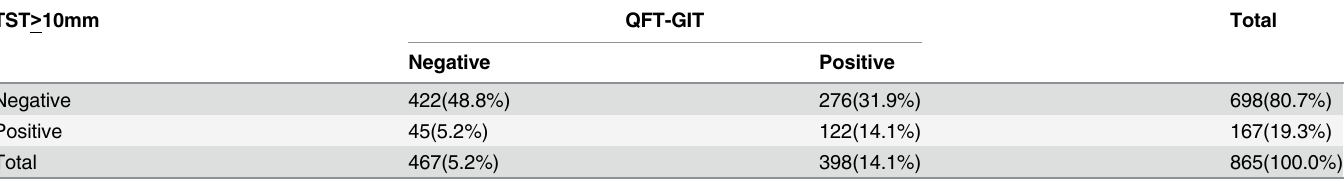
Table 7. Agreement between TST and QFT-GIT Results in